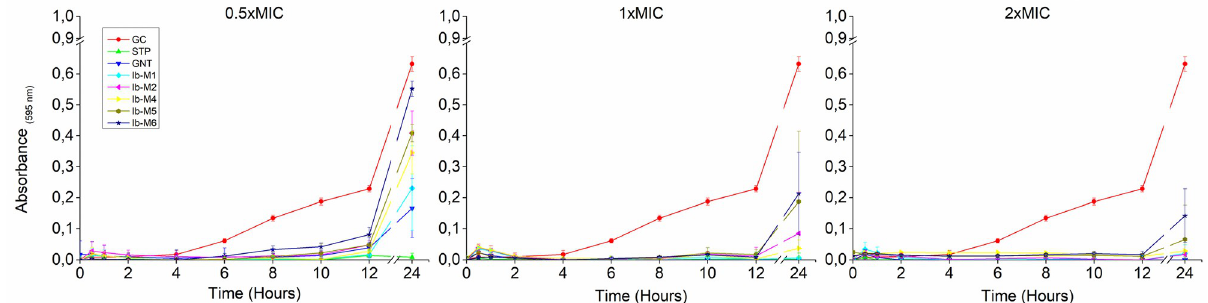
Fig 2. Growth kinetics of E . coli O157: H7 with Ib-M peptides in lag phase. Each concentration was evaluated in quadruplicate. Results were expressed in terms of the arithmetic average ± standard deviation. Data representative of two independent experiments with similar results is shown. GC: Growth Control, STP: Streptomycin, GNT: Gentamicin.